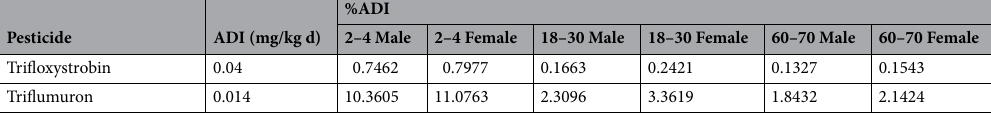
Table 2. Chronic dietary exposure assessment of detected pesticide residues in fruits among different Chinese consumer groups.